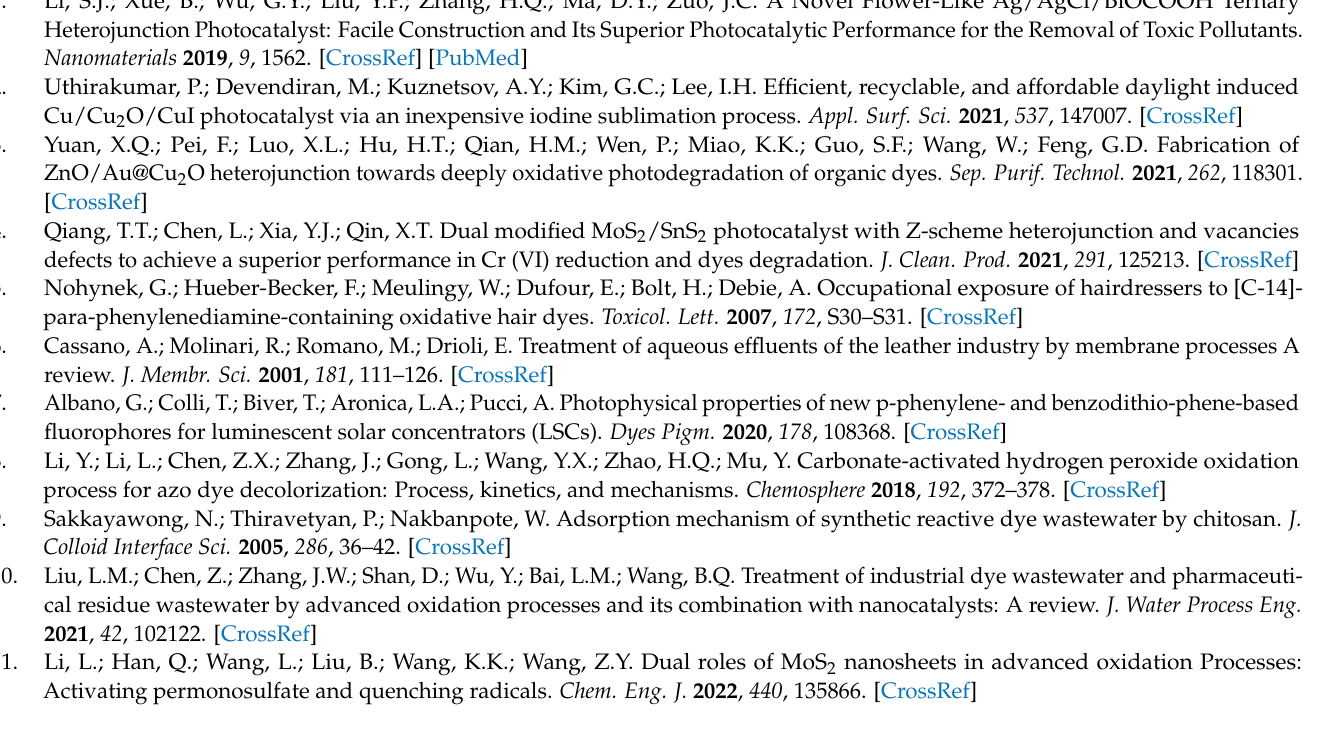
Figure S3: SEM images of a wide range of Cu 40 Zr 60 amorphous alloy ribbon dealloyed in 0.05 M HF for 2 h (a) and the composite sample via deposition at − 0.8 V for 30 min followed by the calcination (b); Figure S4: XPS spectrum of Cu 2p for nanopetals